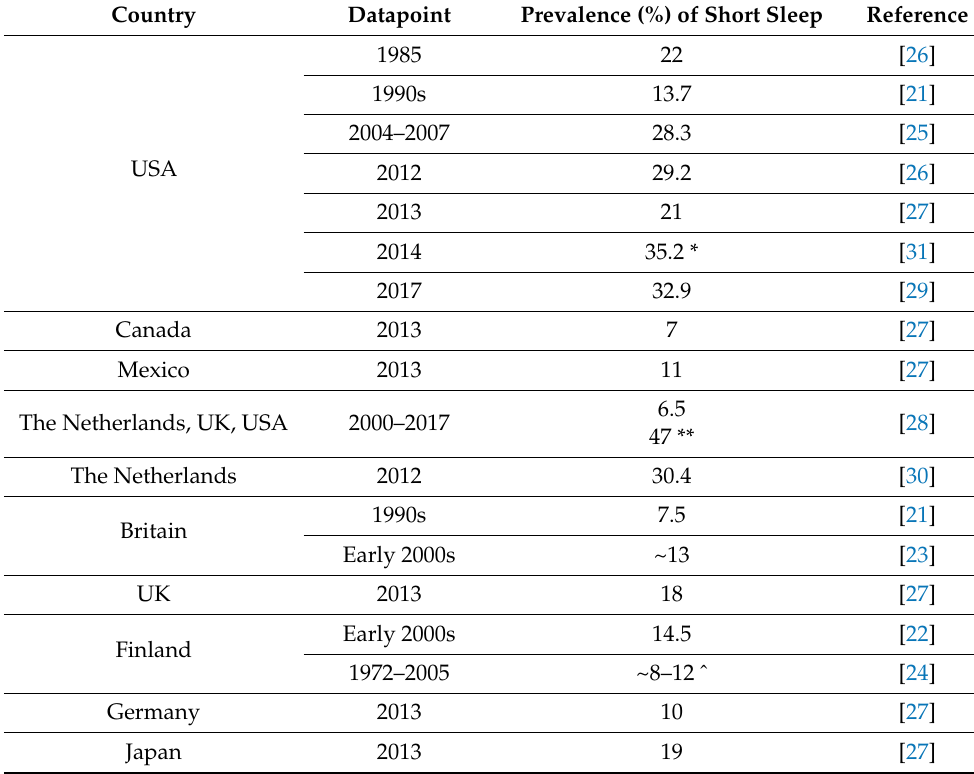
Table 1. Pre-pandemic prevalence of short sleep duration in adults.